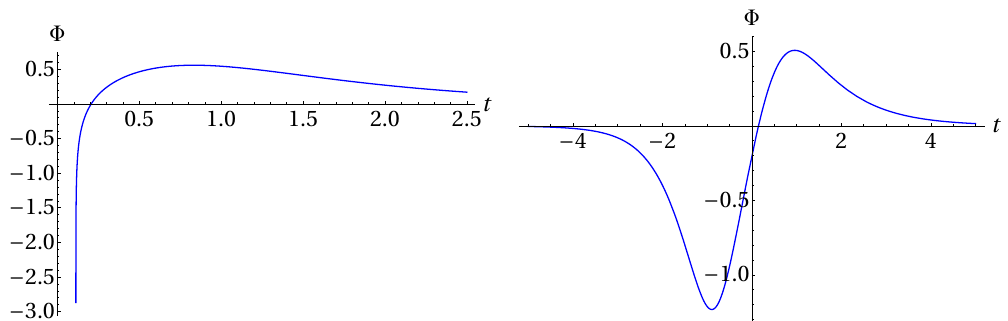
Figure 11. Left panel: an asymptotically classical history of (cid:30) that is initially classically singular, for (cid:8) 0 = 0 : 5, A = 2 : 3 and B = 0. Right panel: an asymptotically classical history of (cid:30) with a bounce in the semiclassical domain, for (cid:8) 0 = 0 : 5, A = 0 : 16 and B = 0.